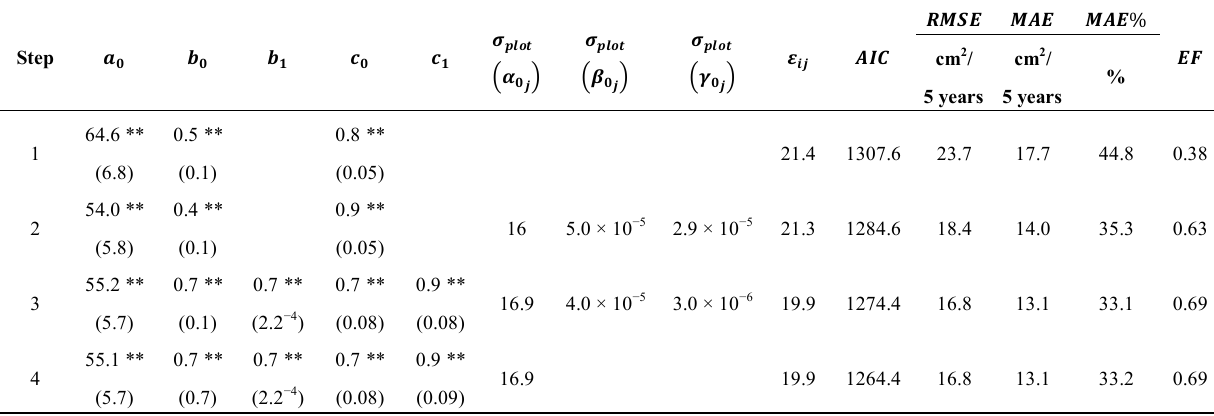
, β , γ corresponds to the 0 j 0 j 0 j is the ij